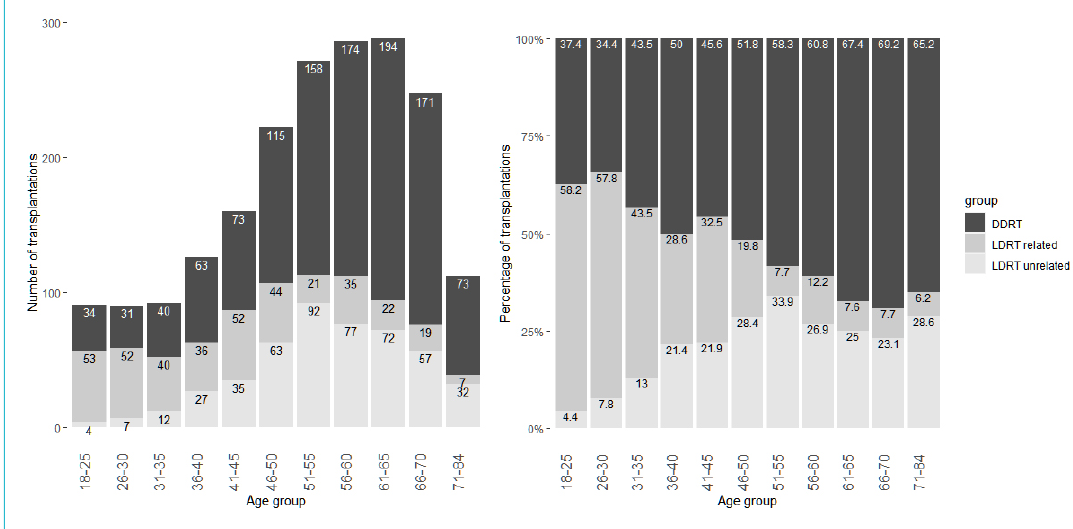
Figure 1: Number (left) and percentage (right) of deceased and living donors by age group of recipients, n = 1985. The group of living donors is further split into donor related (first-degree relatives) and unrelated donors.